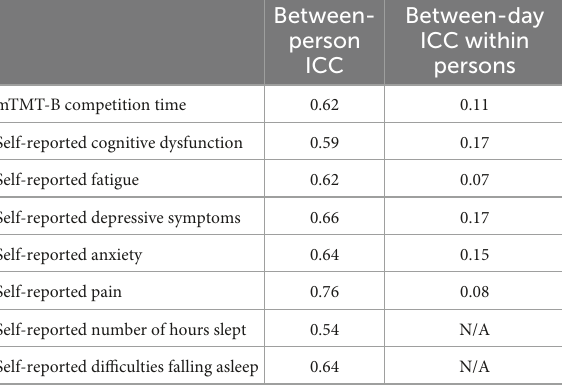
rating/performance. Between-